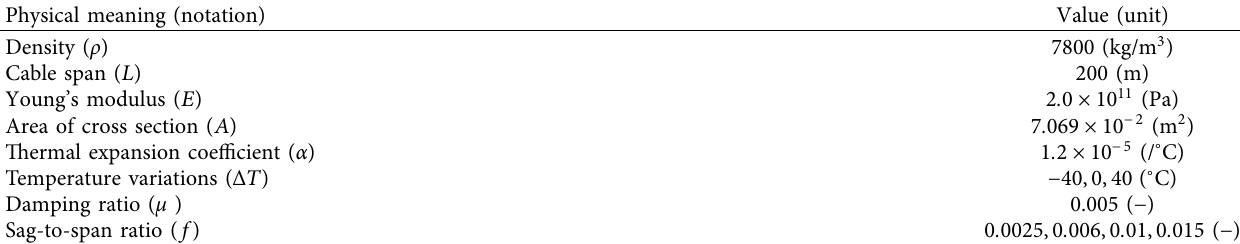
Table 1: Notations and values of physical parameters.